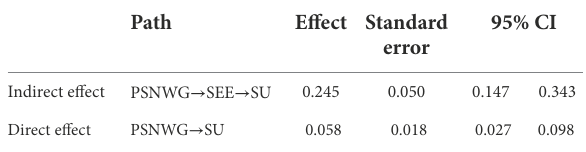
TABLE 4 The results of the mediation effect